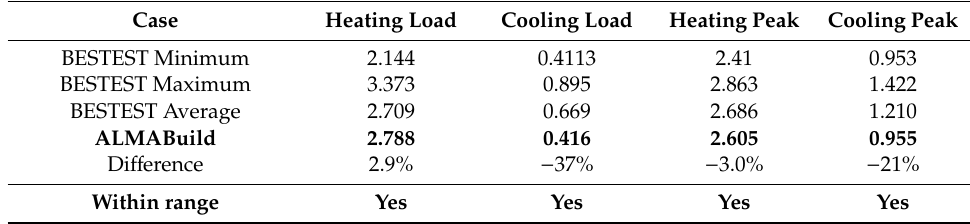
Table 11. Annual heating and cooling load (MWh) and peak (kW) for back zone of Case 960, compared with the minimum and maximum threshold values indicated by BESTEST.